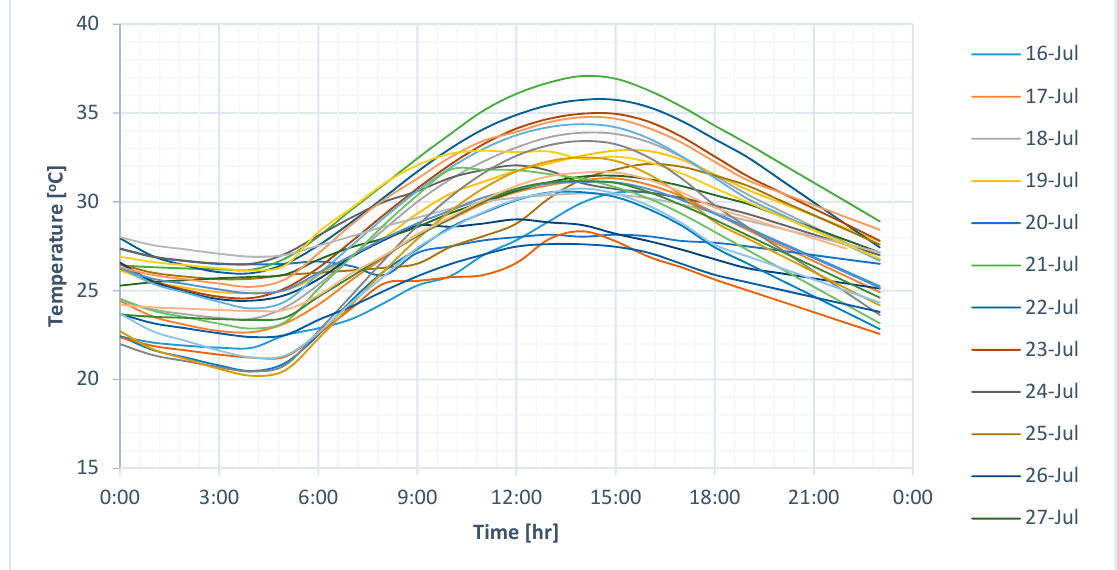
Figure 10. Temperature profiles for the study days.